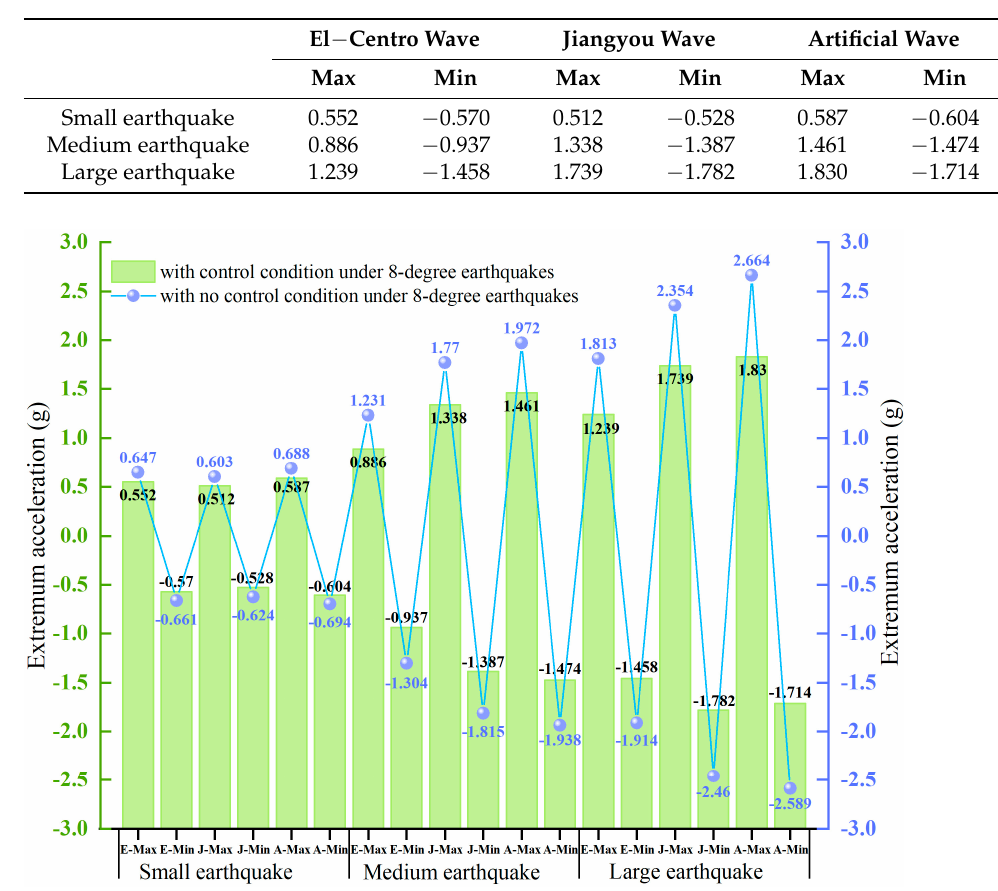
Figure 6. The peak responses of the acceleration of the Small Wild Goose Pagoda. (Note: in the x-coordinate, the letter E stands for “El-Centro Wave”; the letter J refers to Jiangyou Wave; the letter A stands for Artificial Wave.)